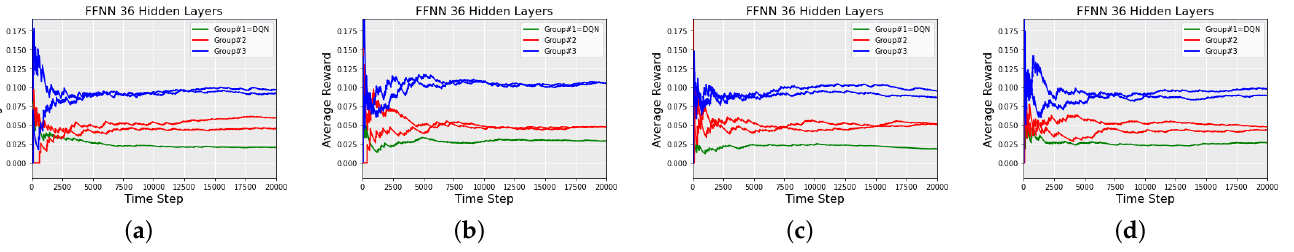
Figure 7. Reward convergence of a heterogeneous MAS, including N = 5 agents in P = 3 different clusters, during 20,000 time steps by considering the novel distance-based reward. ( a ) Average reward of a leaderless MAS. ( b ) Average reward of a leaderless MAS by considering time-delay. ( c ) Average reward of a leader-follower MAS. ( d ) Average reward of a leader-follower MAS by considering time-delay.